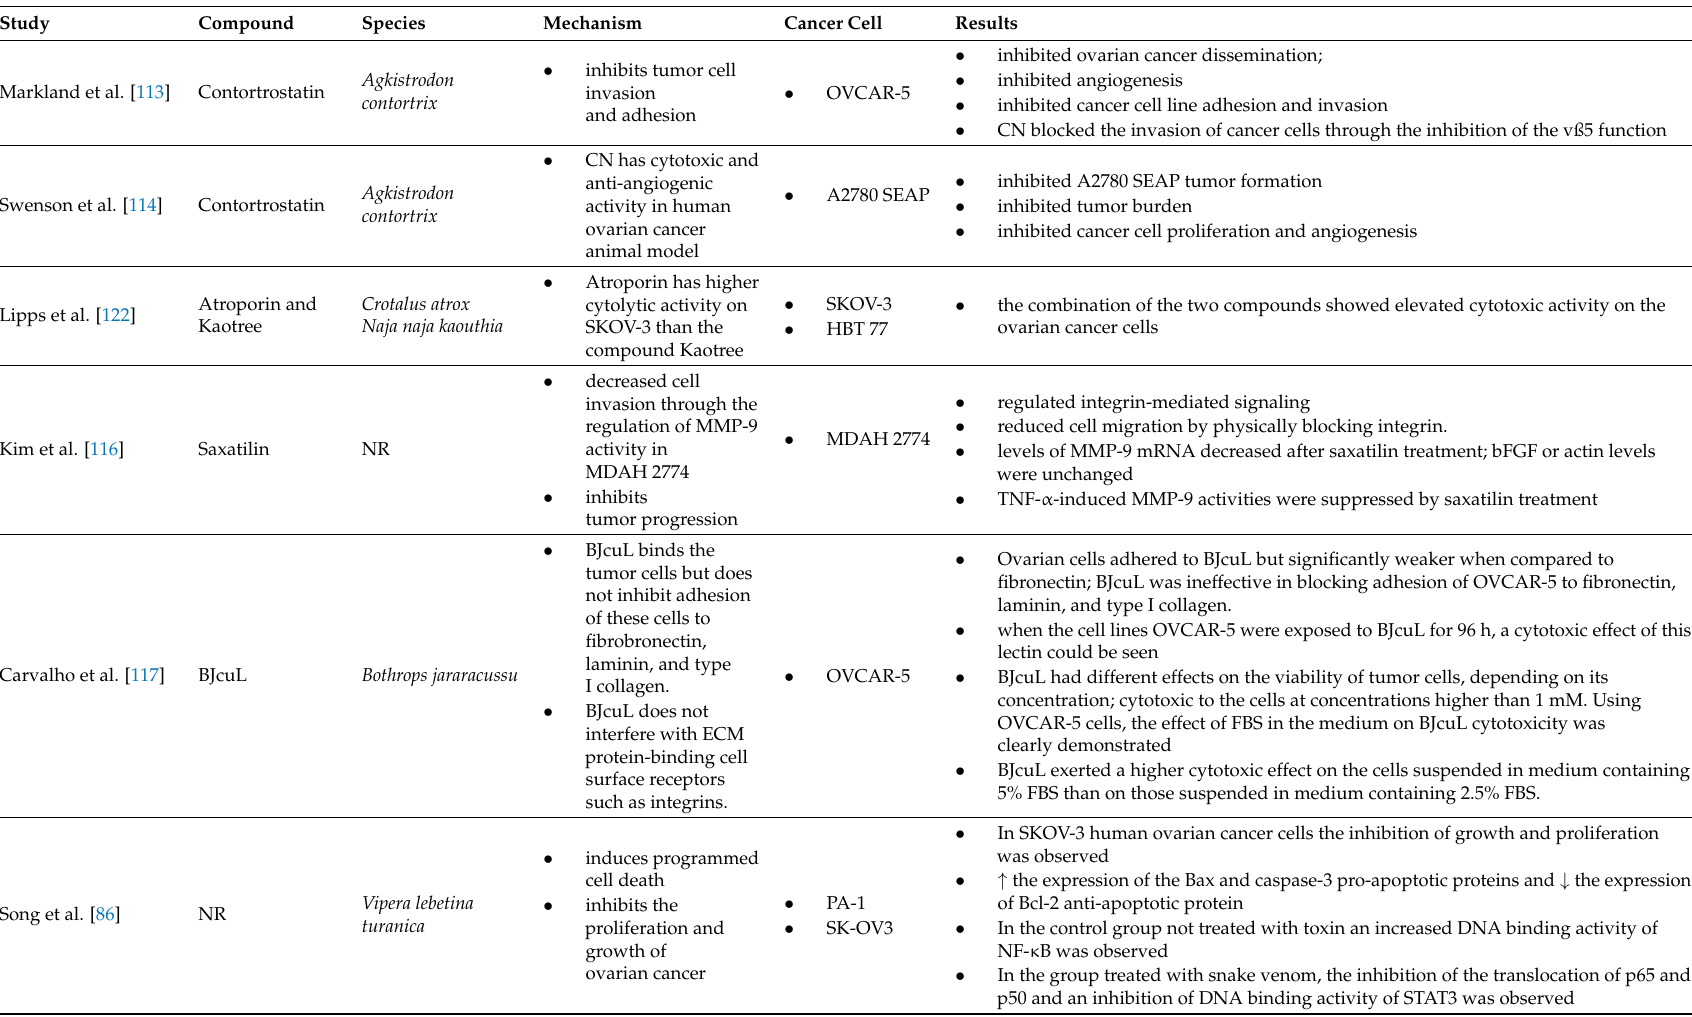
Table 4. Studies of effects of snake venom and their components on ovarian cancer